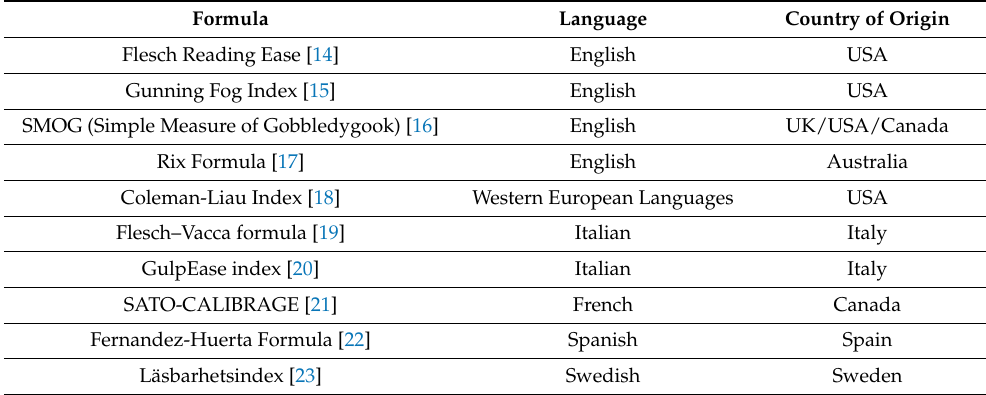
Table 1. Commonly used Readability Formulae to assess ease of reading of texts, such as question- naire